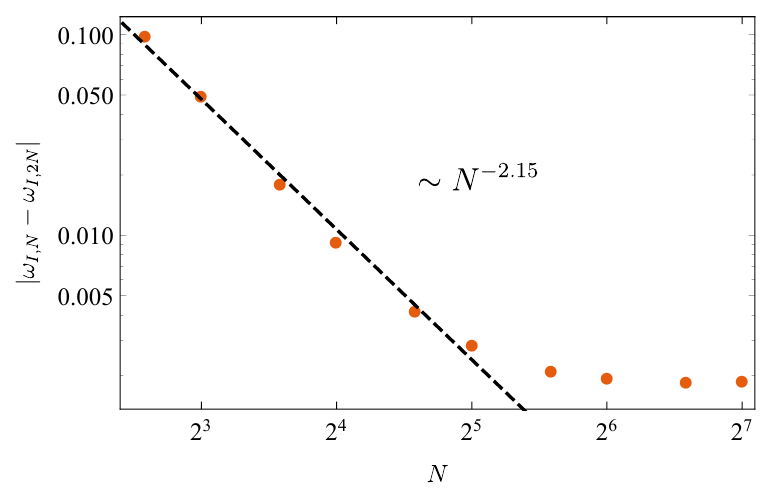
Figure 17 . The convergence behavior of | ω I,N − ω I, 2 N | with respect to the numbers of the grid points. Here, we use E/m 2 = 1 . 0627 and J/m 3 = 0 . 39901 .